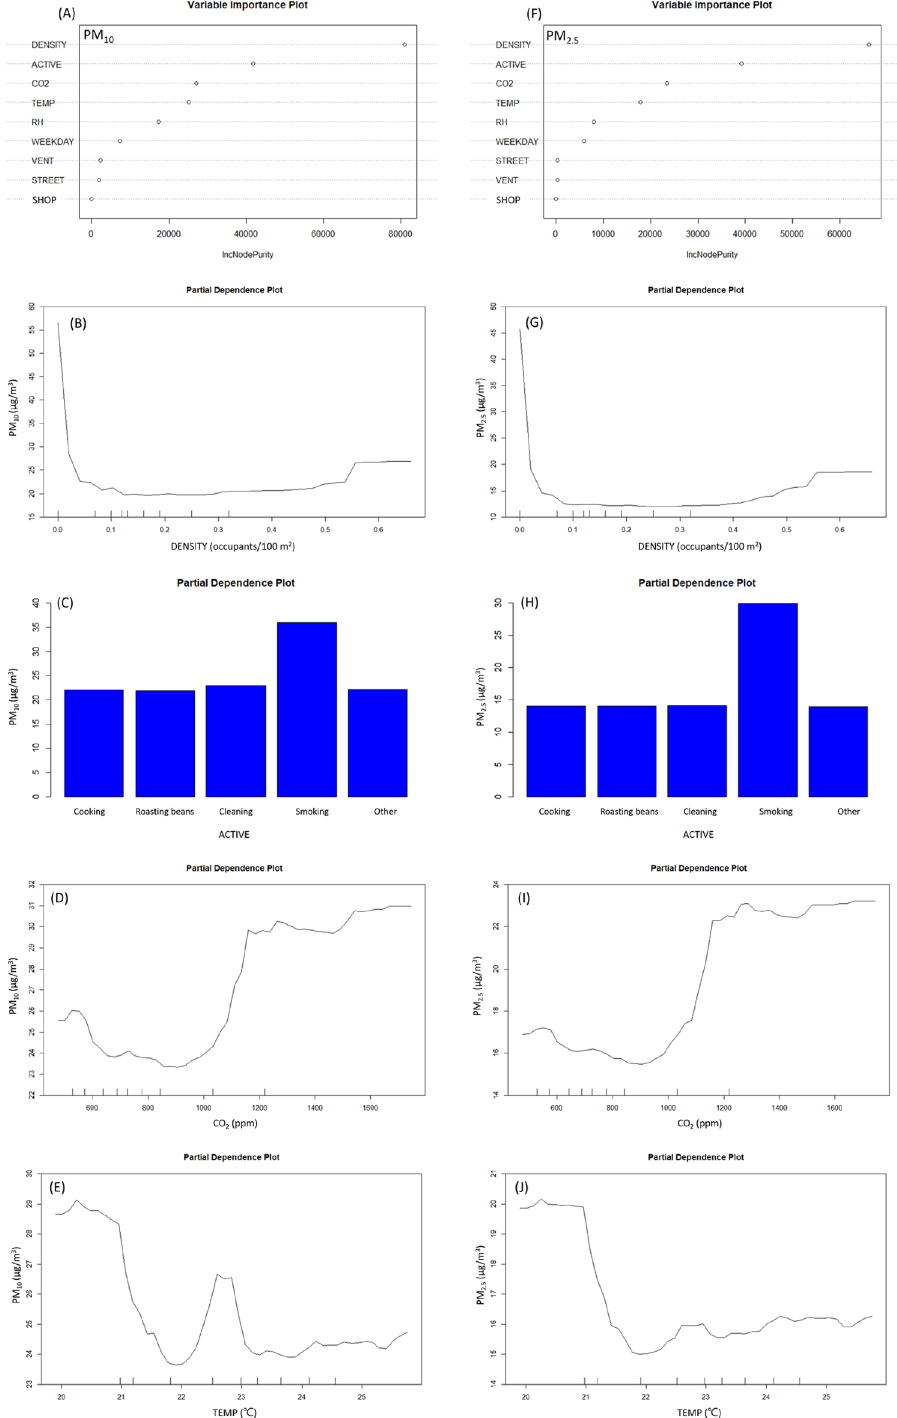
Figure 2. Variable importance rank and partial dependence plot of PM 10 and PM 2.5 from Random Forests models. (PM 10 : particulate matter with an aerodynamic diameter ≤ 10 μm (μg/m 3 ); PM 2.5 : particulate matter with an aerodynamic diameter ≤ 2.5 μm (μg/m 3 ) ACTIVE: Indoor activities; CO 2 : carbon dioxide (ppm); DENSITY: Occupant density (person/m 2 ); RH: relative humidity (%); SHOP: coffee shop A, B, C, D; STREET: locating on the main traffic street; TEMP: temperature(°C); VENT: ventilation